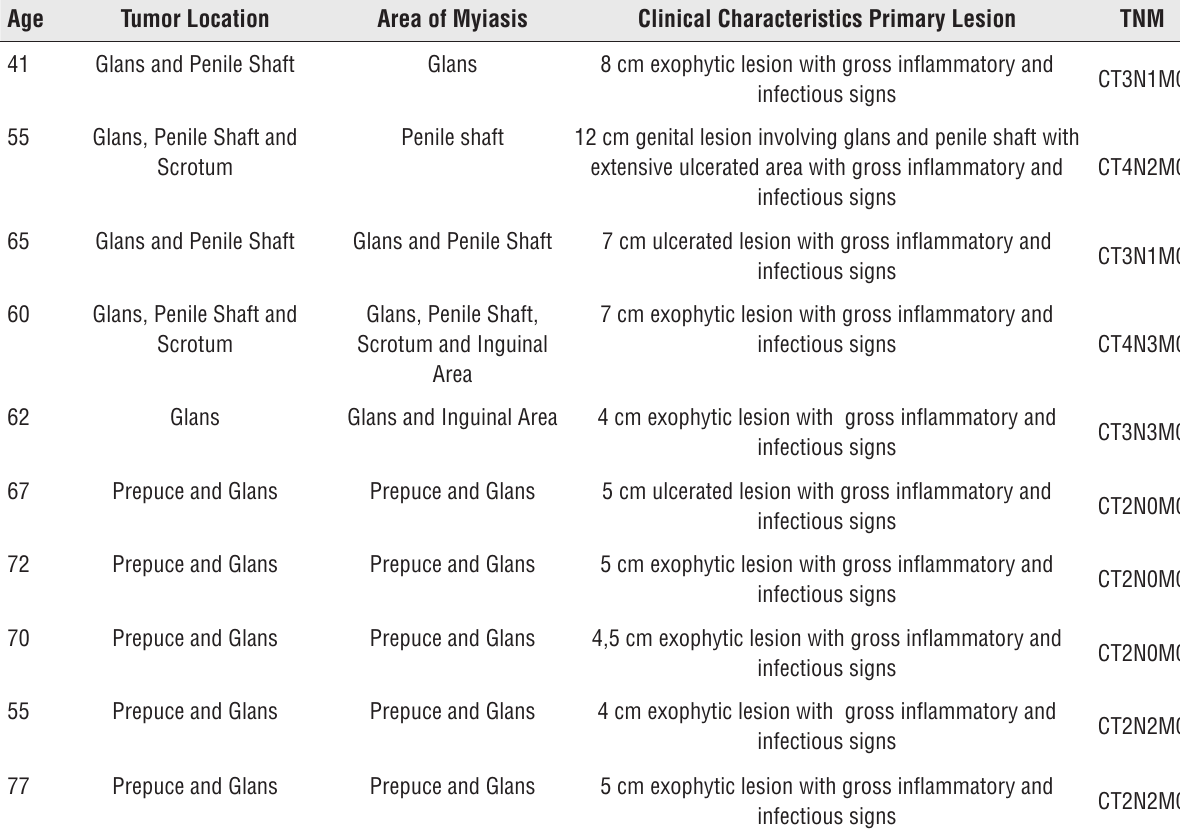
Table 1 - Clinical characteristics of primary lesion, patient’s age, anatomical area of myiasis infestation, primary tumor location, and clinical 2002 TNM